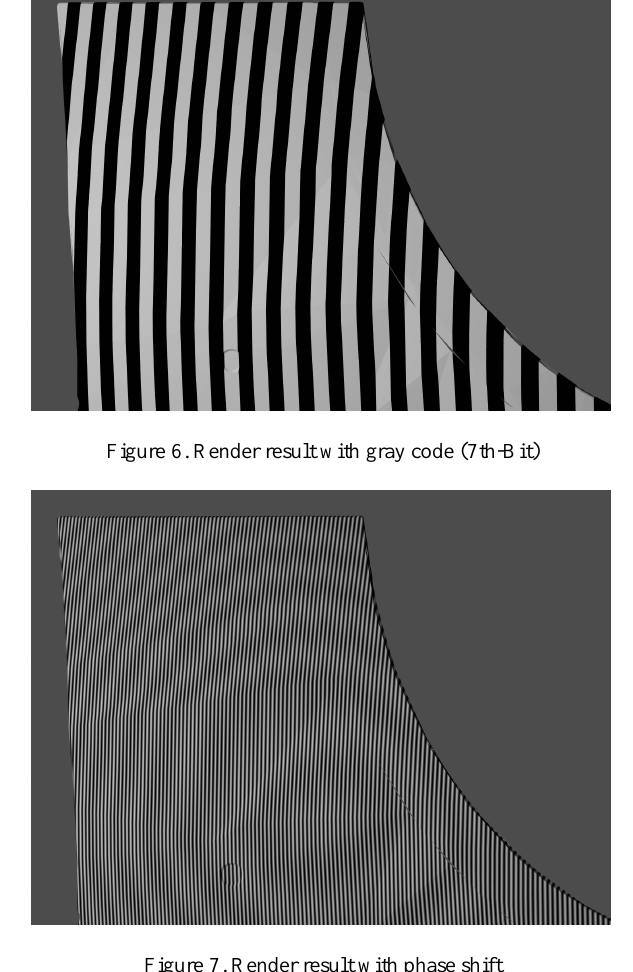
Figure 7. Render result with phase shift